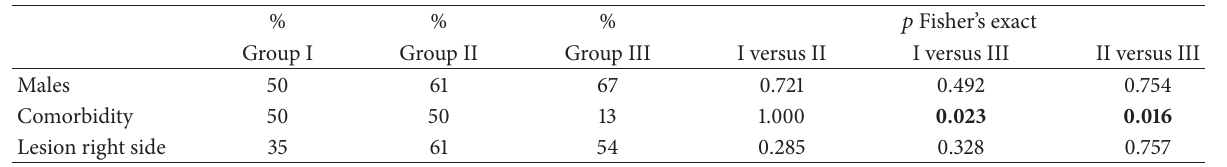
Table 1: Qualitative